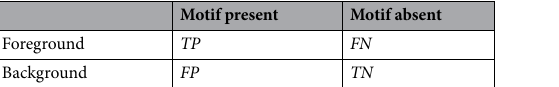
Table 1. Contingency table. Here TP and FP stand for true and false positives, TN and FN for true and false negatives,